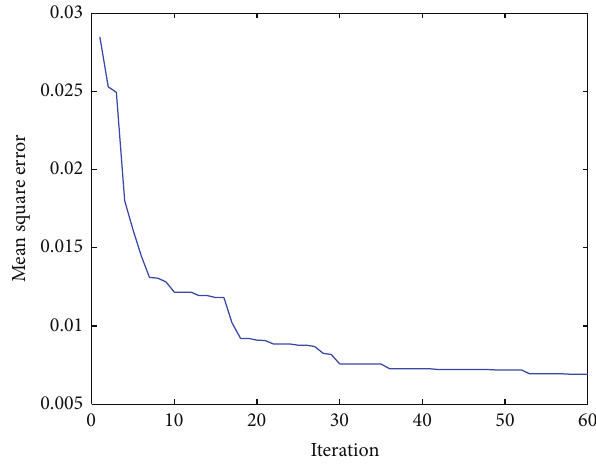
Figure 4: The QPSO-FWNN convergence curves. Table 1: Performance comparison of the six prediction